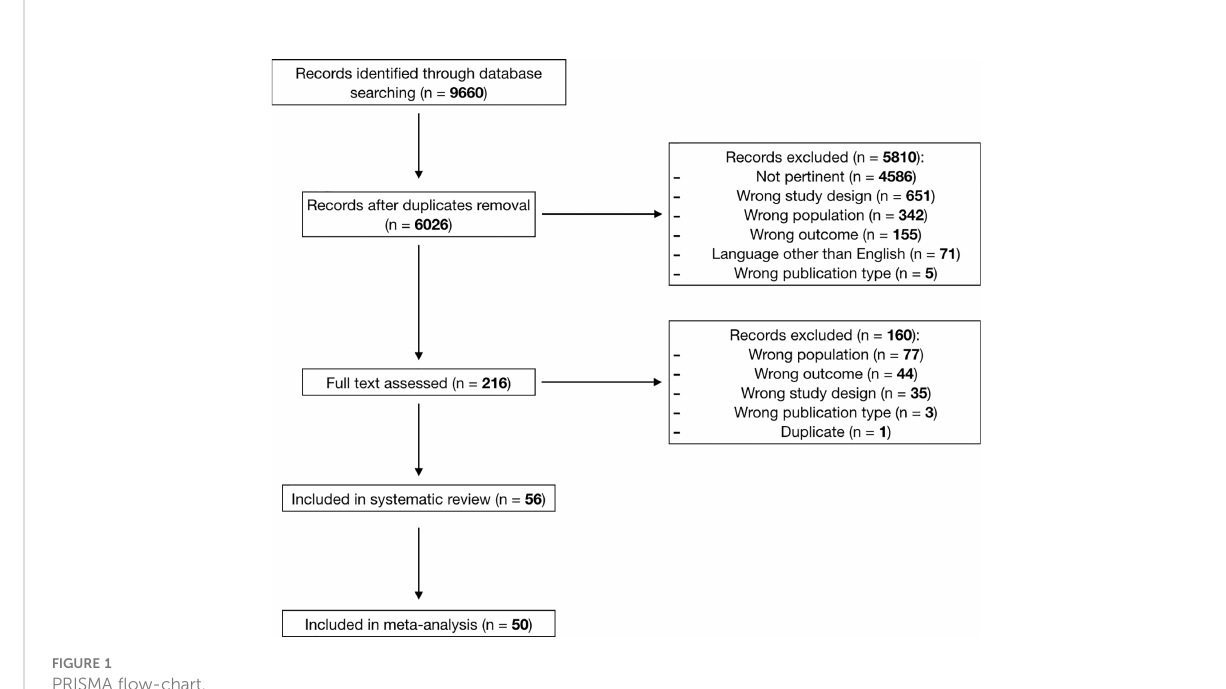
FIGURE 1 PRISMA fl